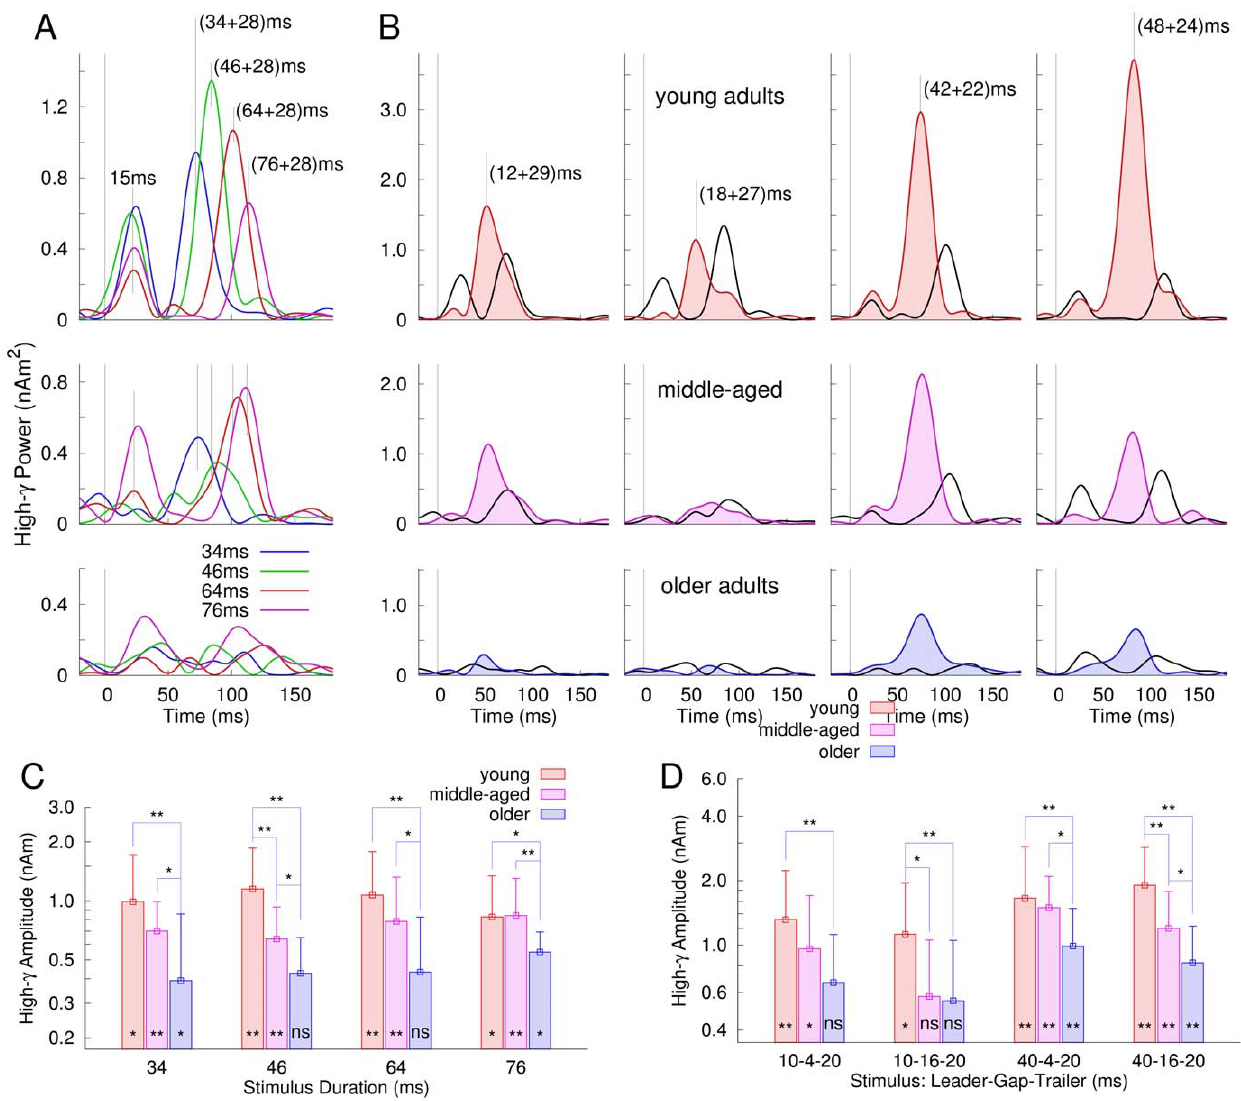
Figure 8. Time courses of activity in the higher gamma band (72–98 Hz) in the right auditory cortex. A : The responses to the no-gap stimuli exhibit two peaks, the first 15 ms after stimulus onset, the second 28 ms after stimulus offset. The response amplitudes decline with increasing age. B : Time courses of high-gamma responses to gap stimuli are shown in different color for the age groups in comparison to responses to the no-gap stimuli shown as black lines. The main peak in the responses to gap stimuli appears at latency between those of the onset and offset response in the corresponding no-gap stimuli. Responses to gap-stimuli were in general larger than responses to no-gap stimuli (note the different scales on the y-axes). C : Bar graphs representing the peak amplitude of the offset response to no-gap stimuli for the three age groups. The error bars denote the upper 95% confidence limits for the group mean. Results of the analysis of phase coherence across each group are indicated at the base of each bar (*: .05 # p , 0.01, **: p # 0.01, ns: not significant). D : Bar graphs of the amplitudes of high-gamma responses to gap stimuli.